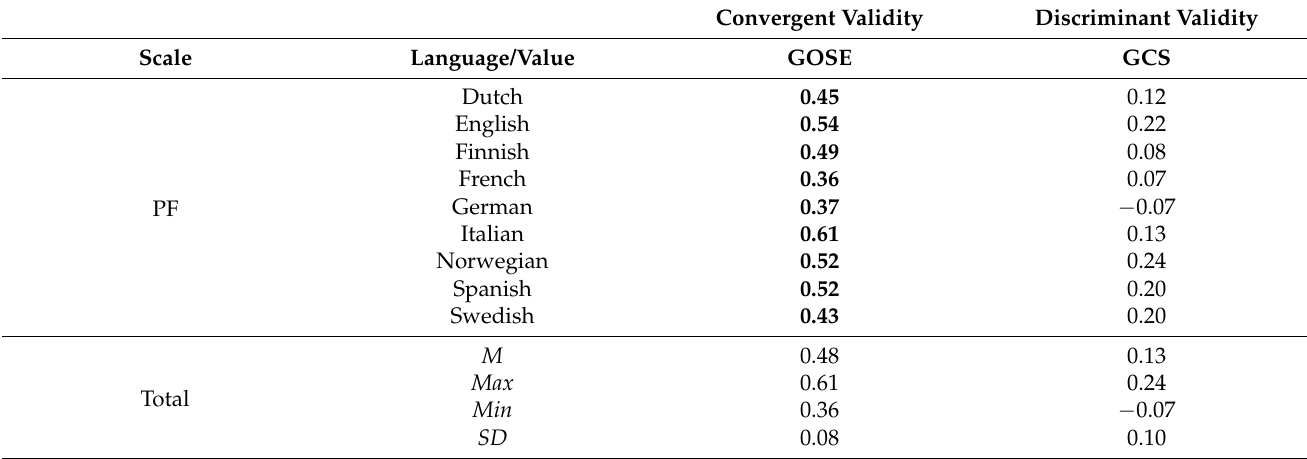
Table A4. Convergent and divergent validity of the SF-36v2